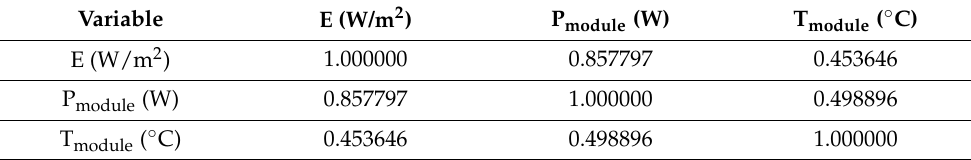
Table 5. The determined correlations between the explanatory